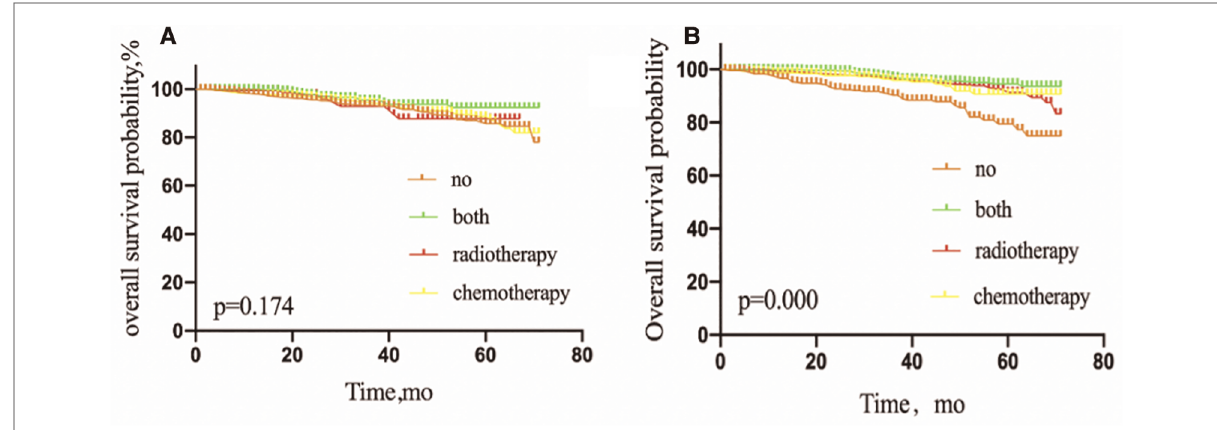
FIGURE 5 Kaplan – Meier curves depicting overall survival between treatment arms strati fi ed by mastectomy ( A ) or breast-conserving surgery ( B ) in patients with breast cancer with sentinel lymph node micrometastases treated with sentinel lymph node biopsy alone. NO patients treated with no adjuvant therapies; BOTH patients treated with both adjuvant chemotherapy and radiotherapy; RADIOTHERAPY patients treated with adjuvant radiotherapy; CHEMOTHERAPY patients treated with adjuvant chemotherapy.